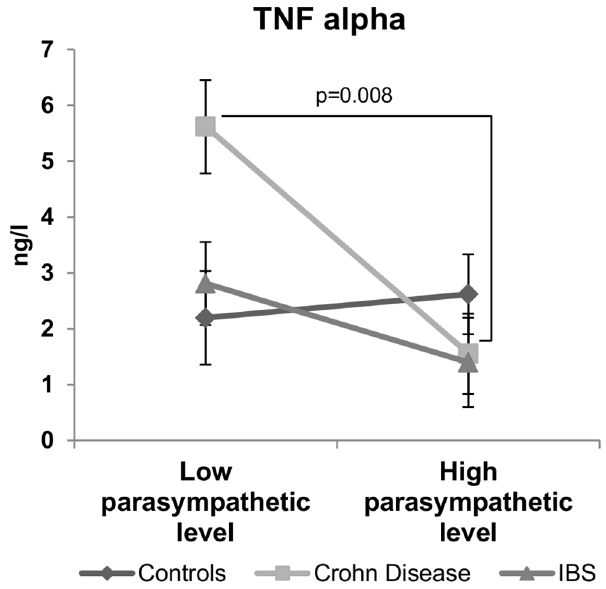
Figure 3. Specific inverse relationship between the resting parasympathetic vagal tone and TNF-alpha plasma level in CD patients. CD patients with low parasympathetic vagal tone exhibit a higher level of TNF-alpha than those with high parasympathetic vagal tone. This inverse relationship was not observed in controls or IBS patients. Data are expressed as mean 6 sem. Comparisons are made between the high and low parasympathetic level subgroups using permutations